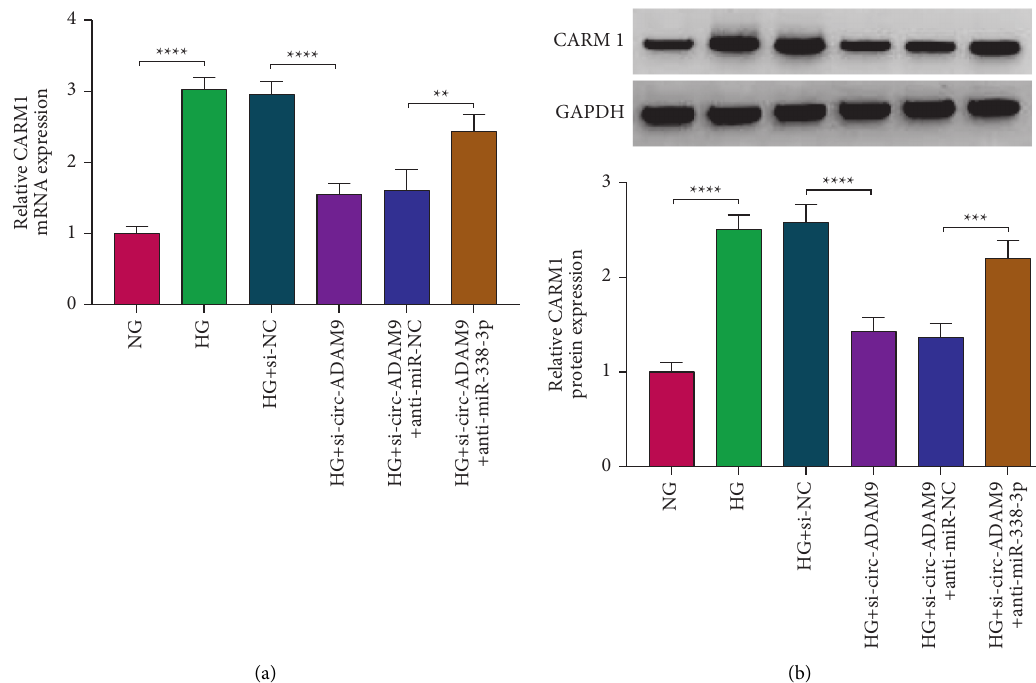
Figure 8: Circ-ADAM9 sponged miR-338-3p to regulate CARM1. The mRNA and protein expression of CARM1 was measured by qRT- PCR (a) and WB analysis (b) in ARPE-19 cells co-transfected with si-circ-ADAM9 and anti-miR-338-3p, respectively. ∗∗ P < 0 . 01, ∗∗∗ P < 0 . 001, and ∗∗∗∗ P < 0 .